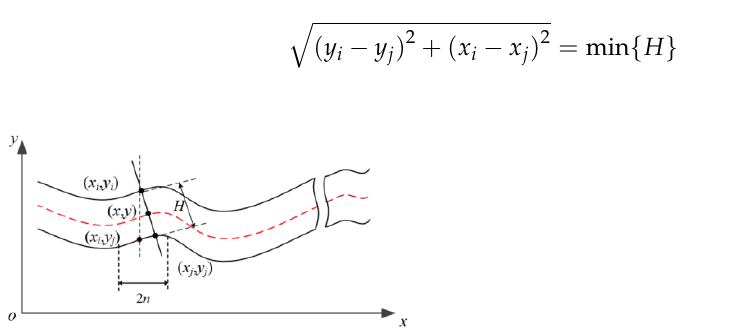
Figure 5. Graphical demonstration of calculating pixel coordinates of the central axis.